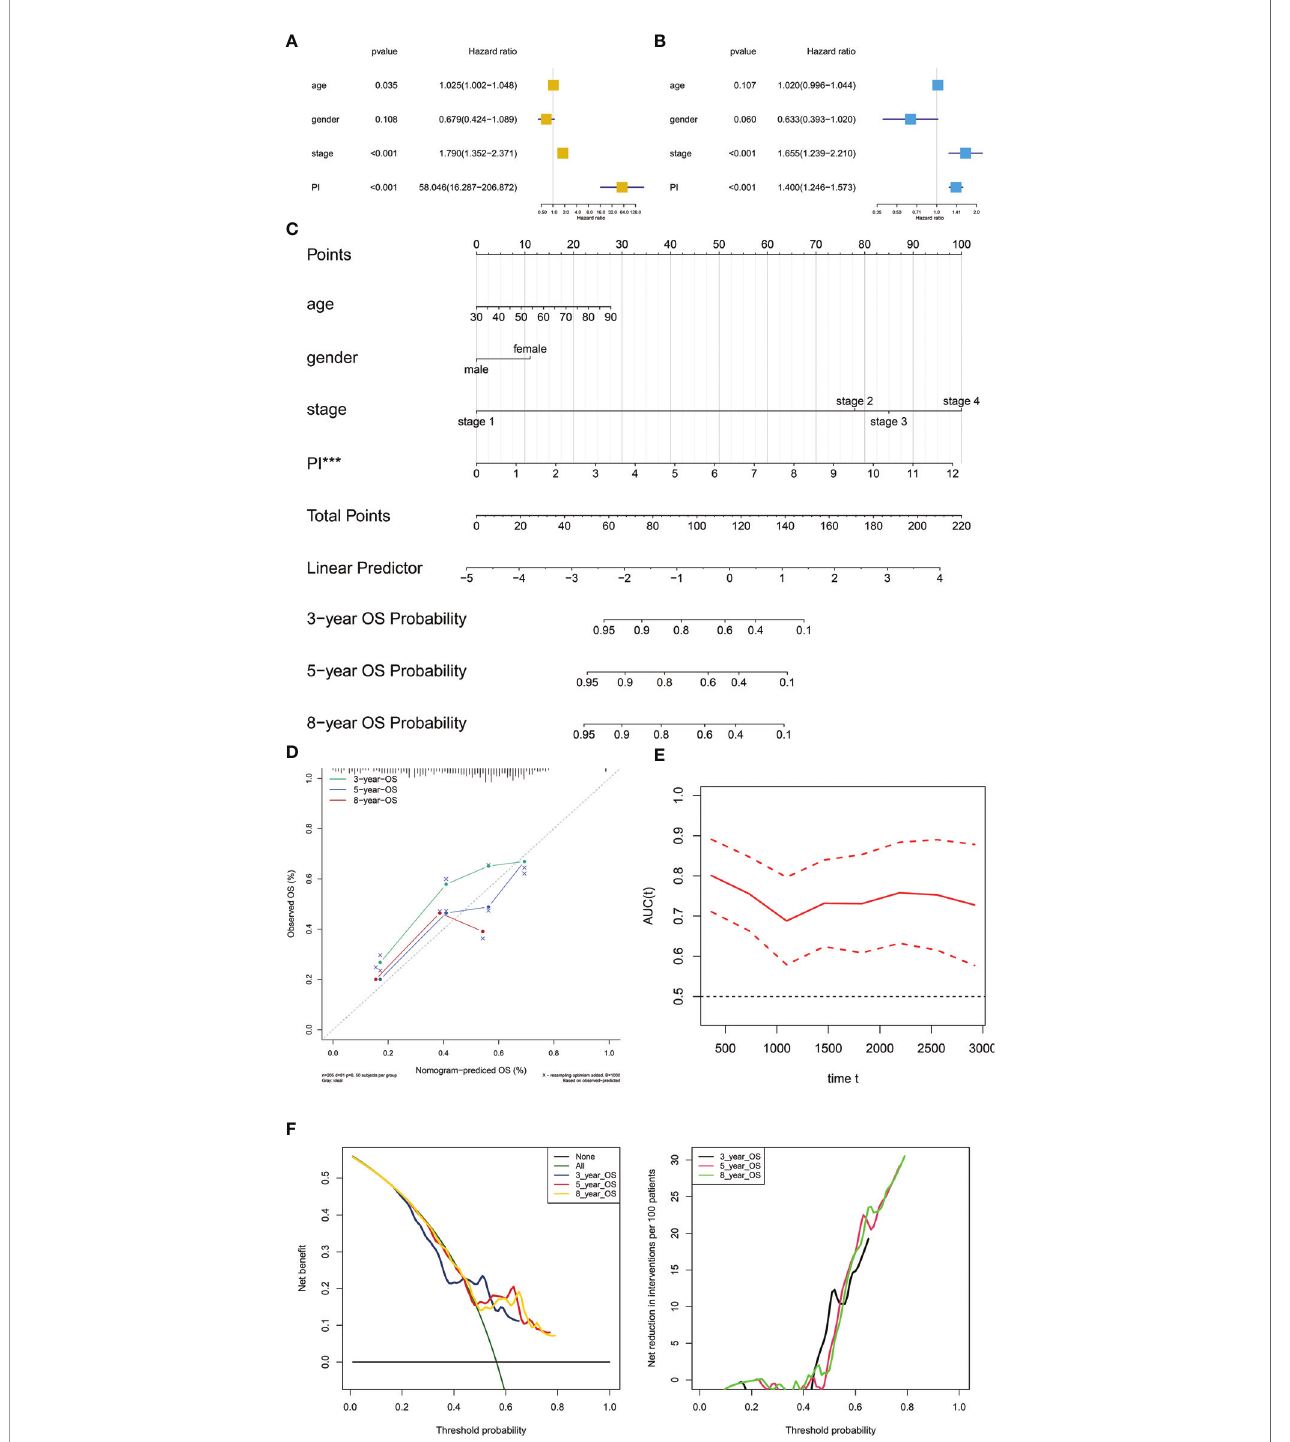
FIGURE 8 | Independent prognosis analysis and construction of the prognostic nomogram. The univariate (A) and multivariate (B) Cox regression model corrected by demographics and stage. The constructed prognostic nomogram based on the multivariate Cox model (C) . The calibration curve illustrated acceptable calibration of the prognostic nomogram (D) . Additionally, the decision curve and time-related ROC with 95% con fi dence interval were also conducted to illustrate the patient bene fi t and the discrimination of the nomogram (E, F) . (***P < 0.001; **P < 0.01; **P <